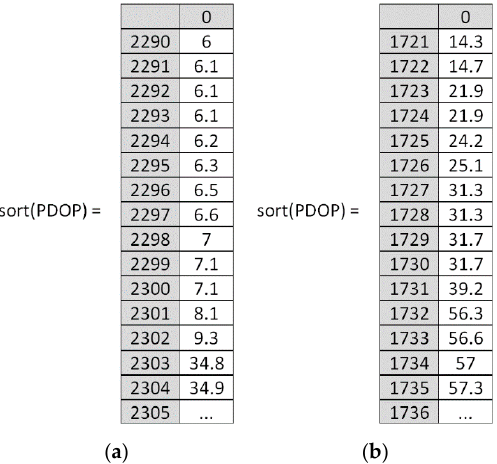
Table 4. The mean and minimum PDOP and the NoS used by the five GNSS geodetic receivers (T1– T5) in measurements during the journeys, with the use of RTK corrections, from GPS/GLONASS and GPS/GLONASS/Galileo satellites.